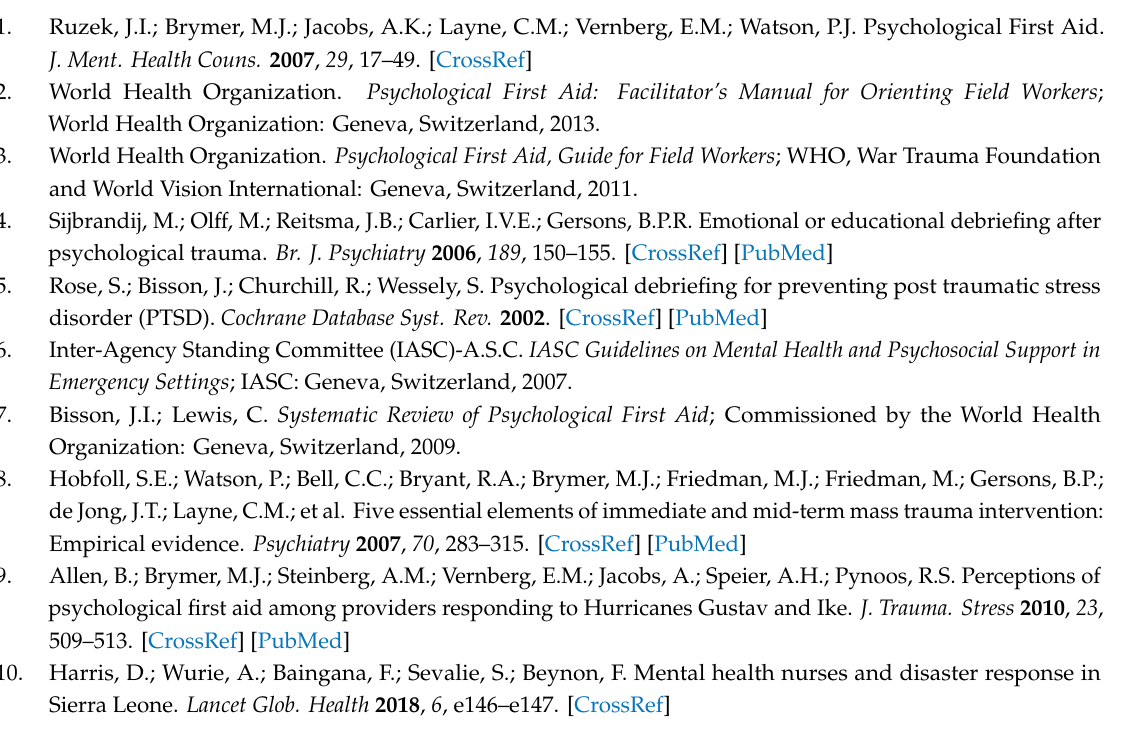
Table S1: Fidelity of training to original Psychological First Aid model checklist. Table S2: Summary statistics and results from mixed model analysis of primary and secondary outcomes in Intention-To-Treat sample ( n = 408). Author Contributions: M.S. drafted the manuscript, and all authors (M.S., R.H., R.E., F.O., R.R., L.R., K.S.,